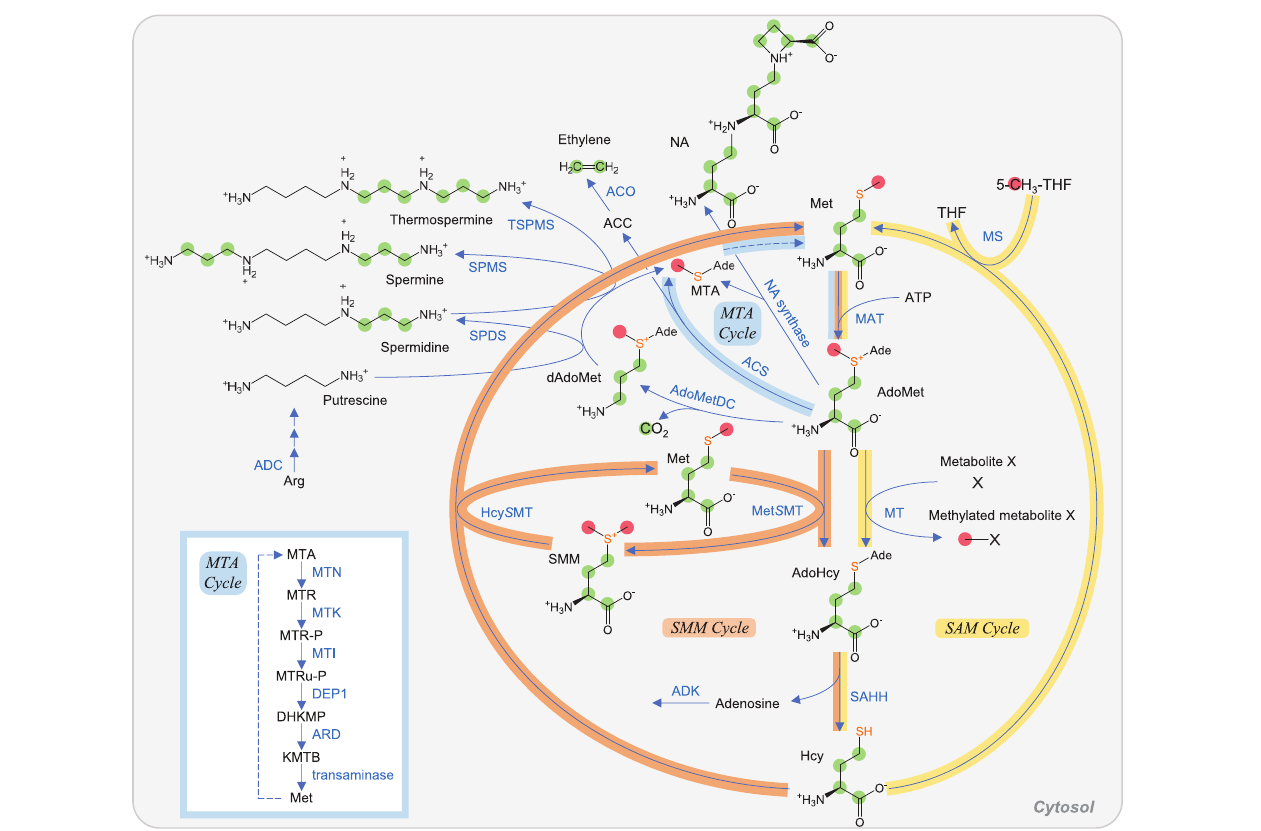
FIGURE 3 | AdoMet metabolism in plant. Carbon atoms of C 1 unit and those derived from Asp are shown as red and green circles, respectively. Sulfur atoms derived from Cys are highlighted in orange. SAM cycle, SMM cycle, and MTA cycle (also known as the Yang cycle or Met salvage cycle) are indicated in yellow, orange, and pale blue, respectively. Among the reactions of the MTA cycle, six steps from MTA to Met are shown in the lower left box. Abbreviations: Ade, adenosyl group. Other abbreviations are listed in Table 1